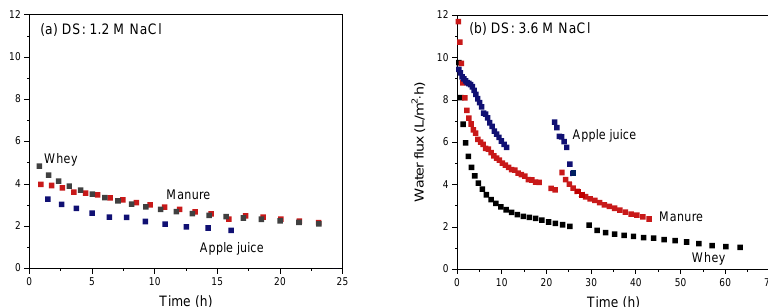
Figure 11. Water flux as a function of the FO operation time using apple juice, manure or whey as FS and using a ( a ) 1.2 M or ( b ) 3.6 M NaCl solution as DS. The intermissions in the curves with 3.6